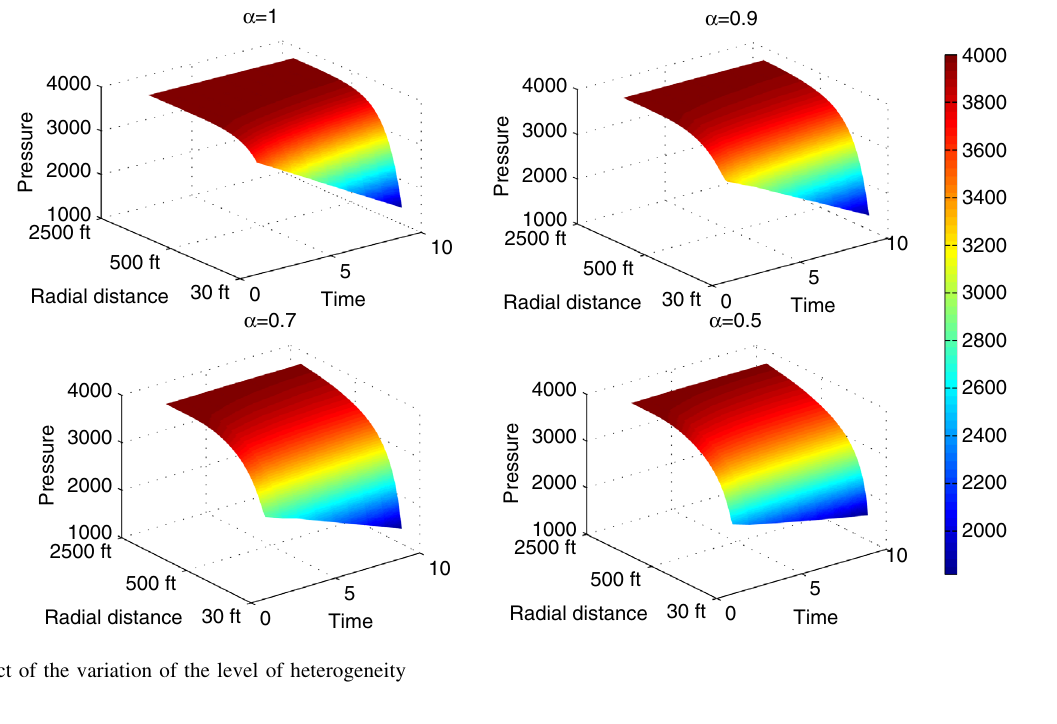
Fig. 3 Comparison of the classical model with the proposed model